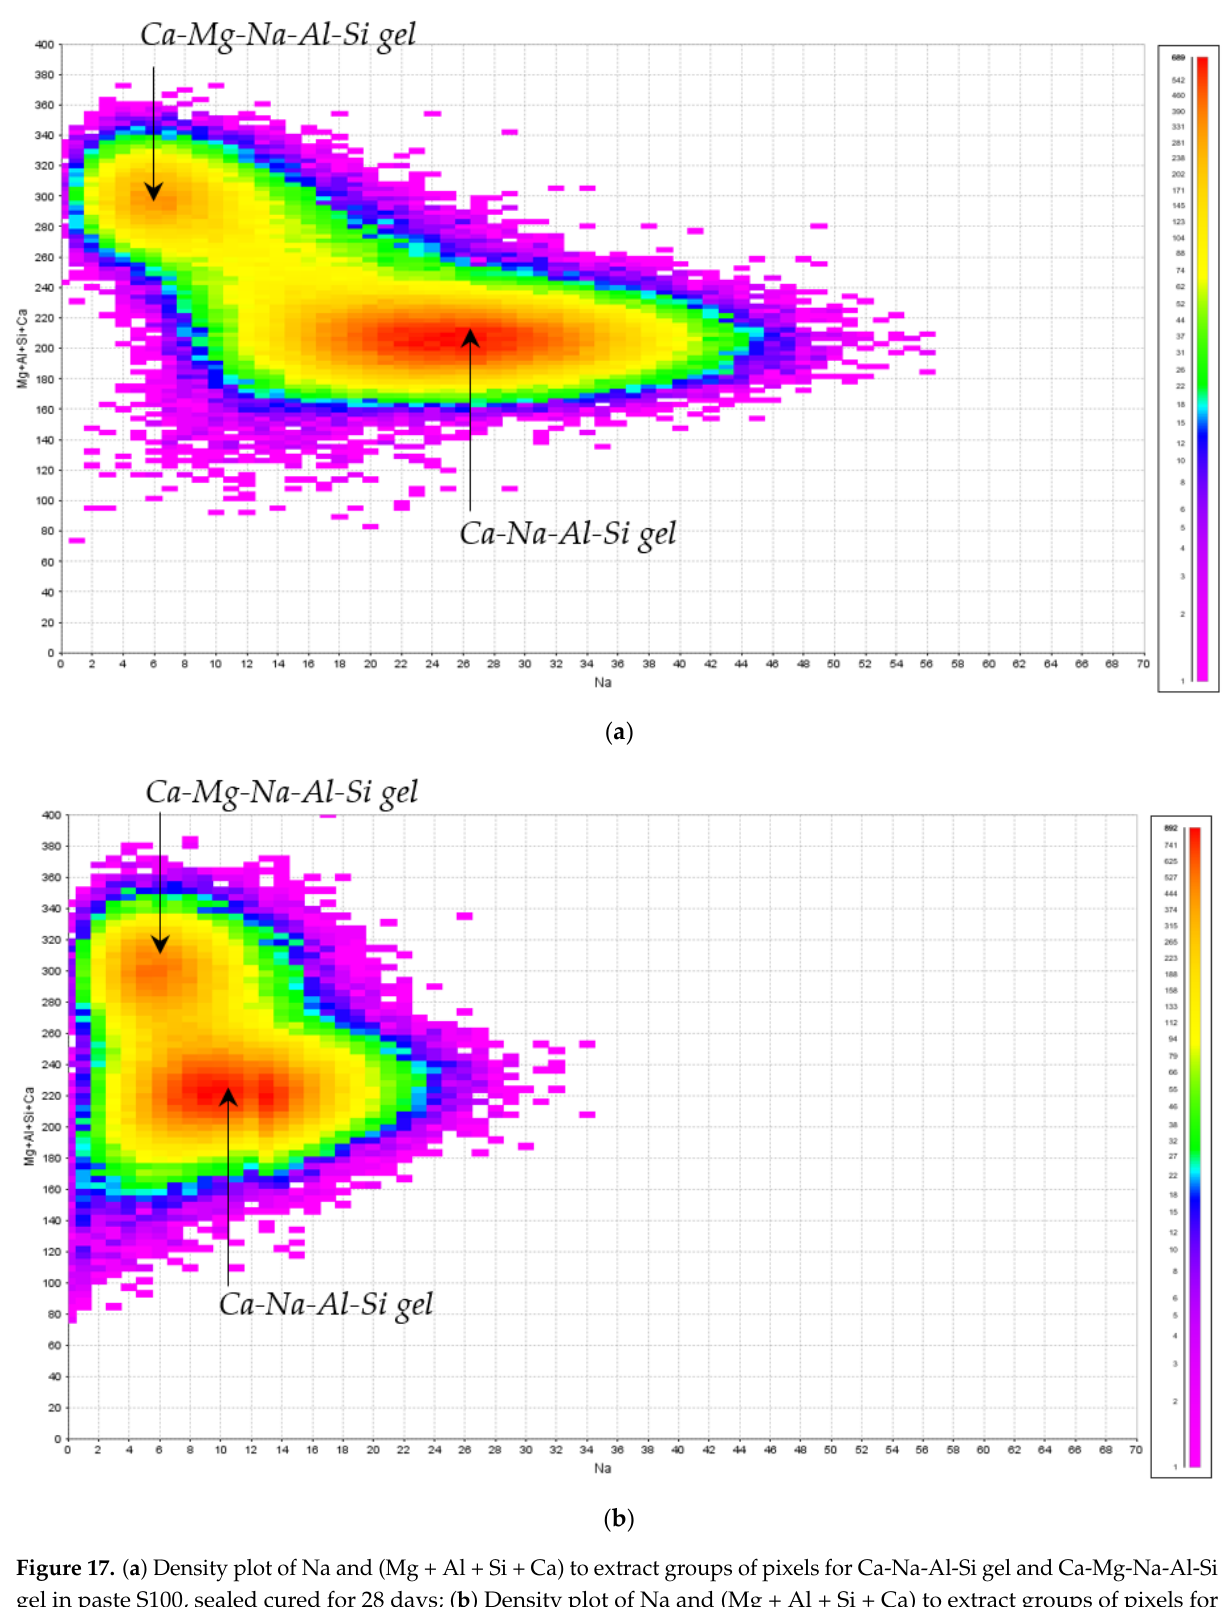
Figure 17. ( a ) Density plot of Na and (Mg + Al + Si + Ca) to extract groups of pixels for Ca-Na-Al-Si gel and Ca-Mg-Na-Al-Si gel in paste S100, sealed cured for 28 days; ( b ) Density plot of Na and (Mg + Al + Si + Ca) to extract groups of pixels for Ca-Na-Al-Si gel and Ca-Mg-Na-Al-Si gel in paste S100 cured and sealed for 28 days. The evolution of the phase proportions of paste S100 is presented in Figure 18. The evolution of the phase proportions is accompanied by the compositional evolution (Table